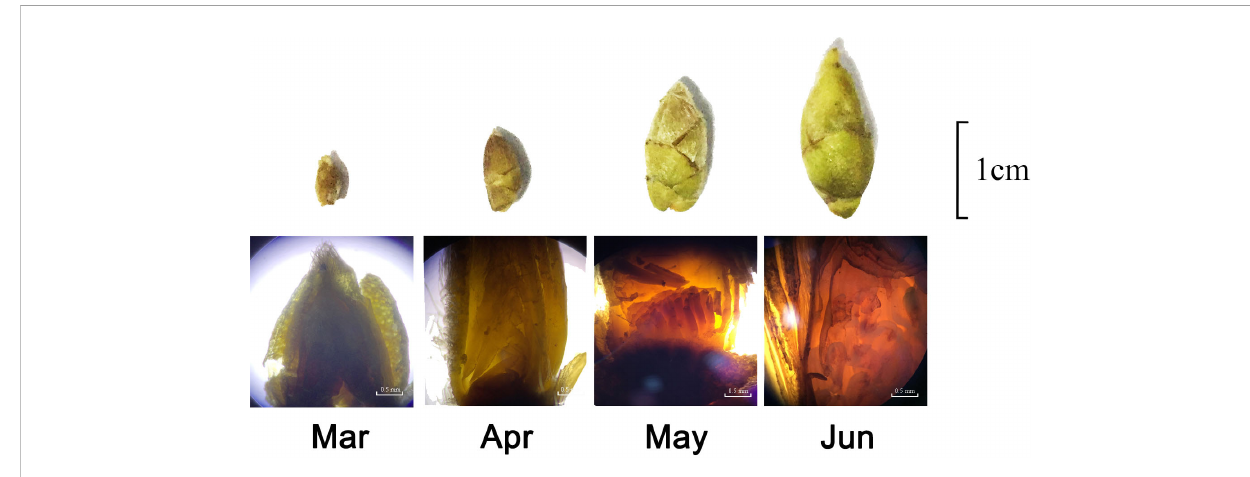
FIGURE 3 Observation on fl ower bud formation of Camellia oleifera .